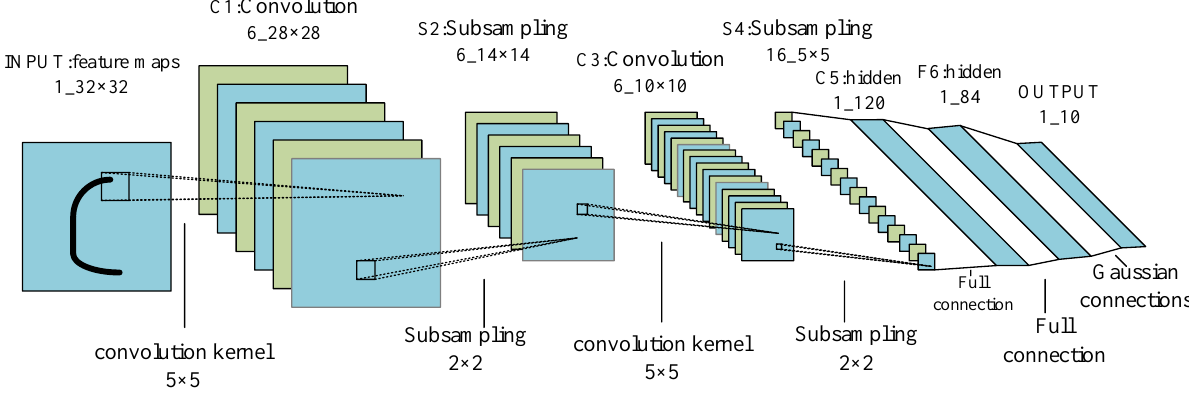
Figure 3. The Lenet-5 model.